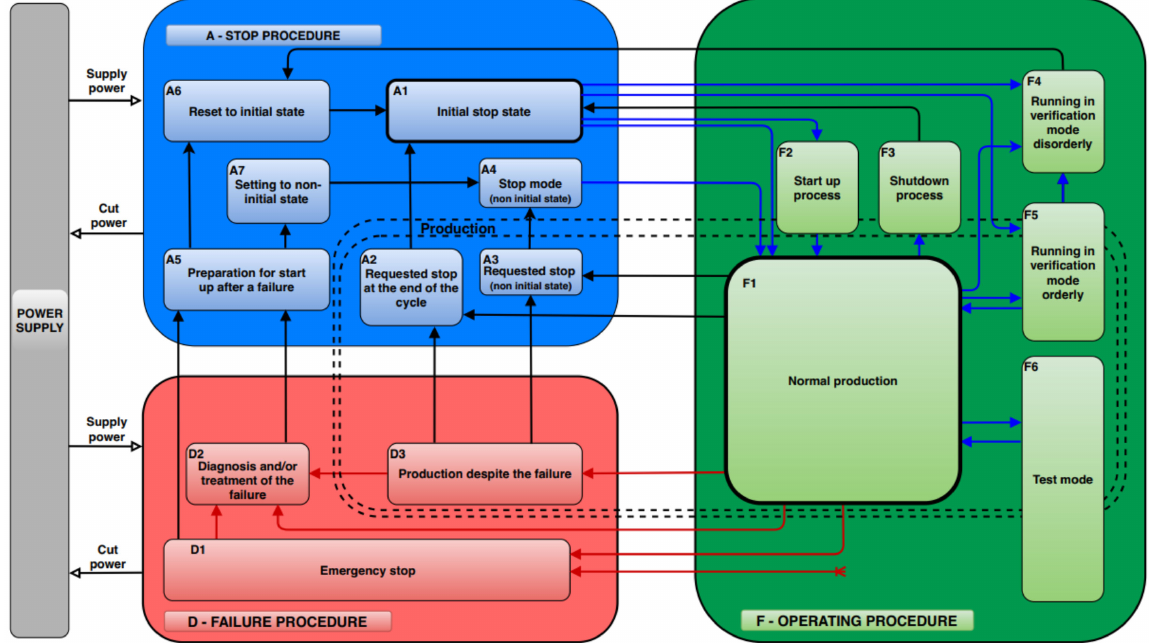
Figure 1. Guide d’etude des modes de marche et d’arr ê t (GEMMA) guide paradigm with its different states and